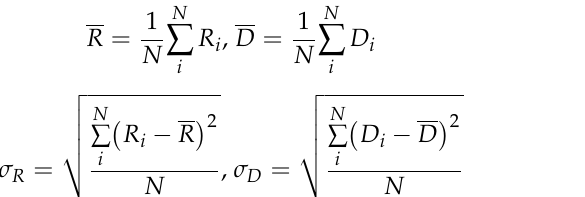
Figure 17. SEM images of the droplets in shear layer of case I part. Figure 18 illustrated the statistics of the droplets morphologies on Figures 16 and 17.